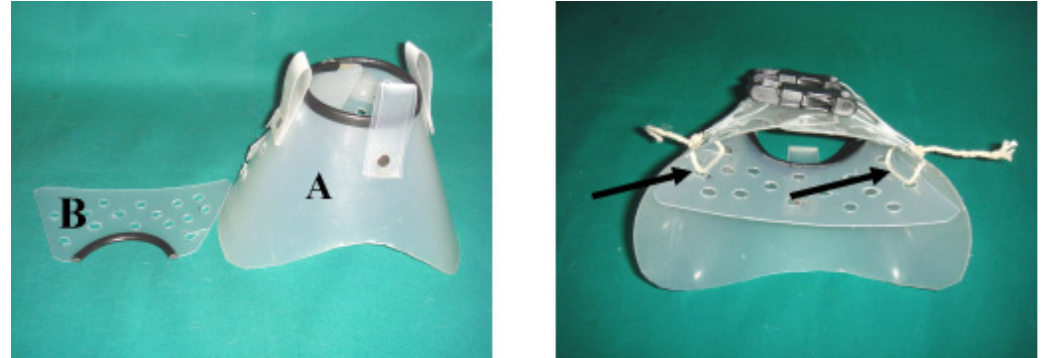
FIGURE 3 – A. Photograph of cervical isolation collar for rabbits, showing the main body of the device ( A ) and the divider for isolating the ears ( B ), separated and supported on a flat surface. B. Detail of the divider attachment on the main body of the device with threaded braces (black arrows).